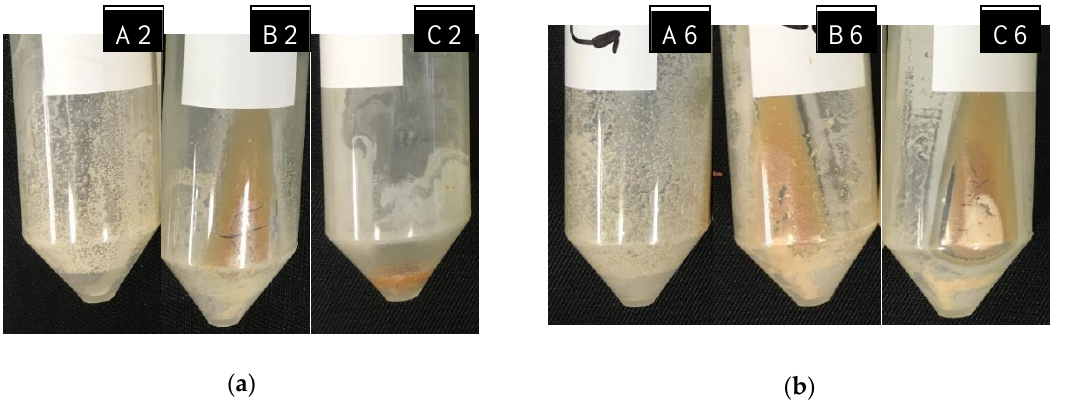
Figure 3. ( a ) Precipitates after 24 h for mixtures A2, B2, and C2; ( b ) precipitates after 72 h for mixtures A6, B6, and C6.